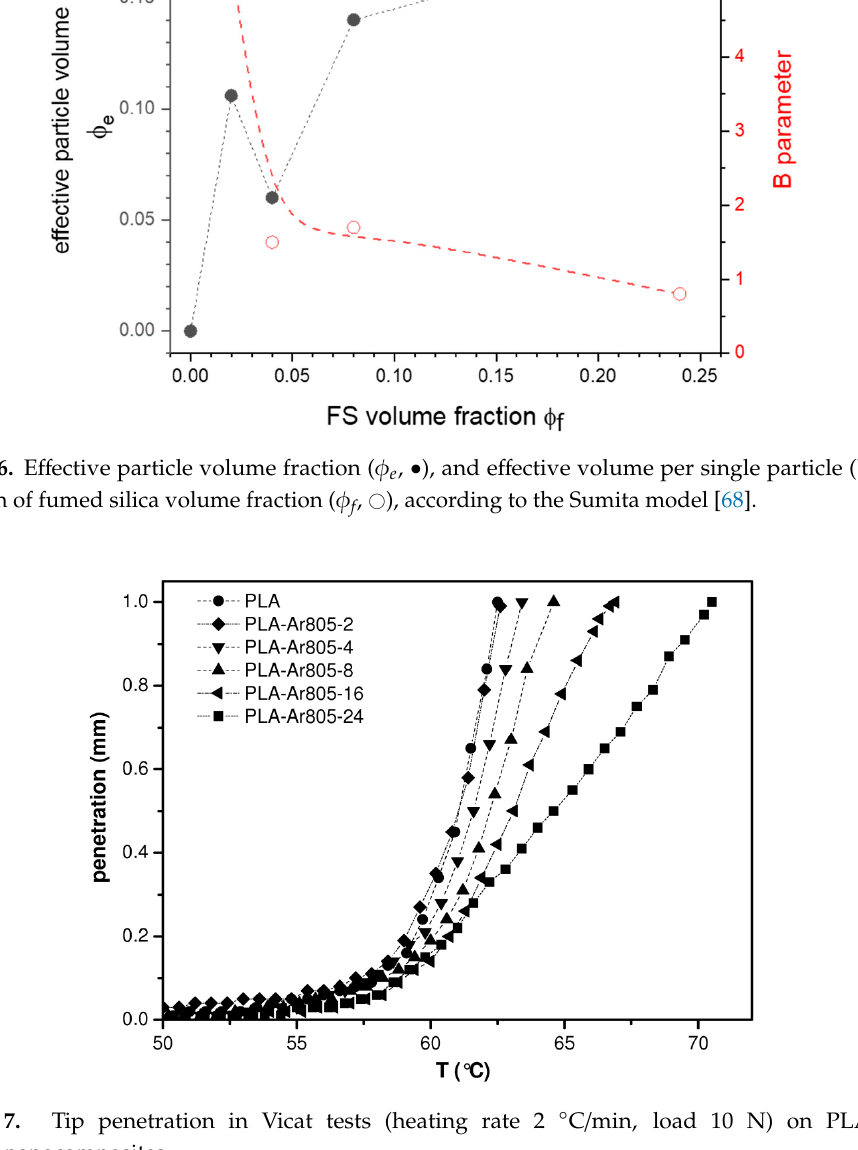
Figure 7. Tip penetration in Vicat tests (heating rate 2 °C/min, load 10 N) on PLA and relative